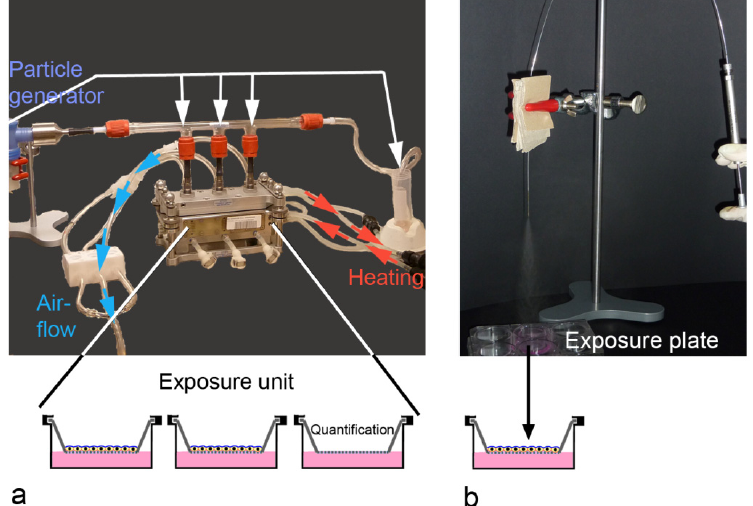
Figure 4. Set-up for aerosol-exposure at the air-liquid interface based on the VitroCell ® (Vitrocell Systems GmbH, Waldkirch, Germany) exposure system ( a ) and by manually generated aerosols (MicroSprayer ® , b ). ( a ) Cells are cultured on transwells and exposed in the compartments of the exposure unit, thermo stabilized by a water bath. Airflow generated by a vacuum pump provides a steady flow of the particle-loaded aerosol, generated in the particle generator (PARI BOY LC Sprint, PARI GmbH, Starnberg, Germany), over the cells. Part of the aerosol that passes the glass tube, is collected at the end of the glass tube and used for particle analysis in the aerosol. Particle deposition on cells is quantified in one compartment of the exposure unit; ( b ) Cells cultured on transwells are exposed in a separate exposure plate to one to three puffs of manually generated